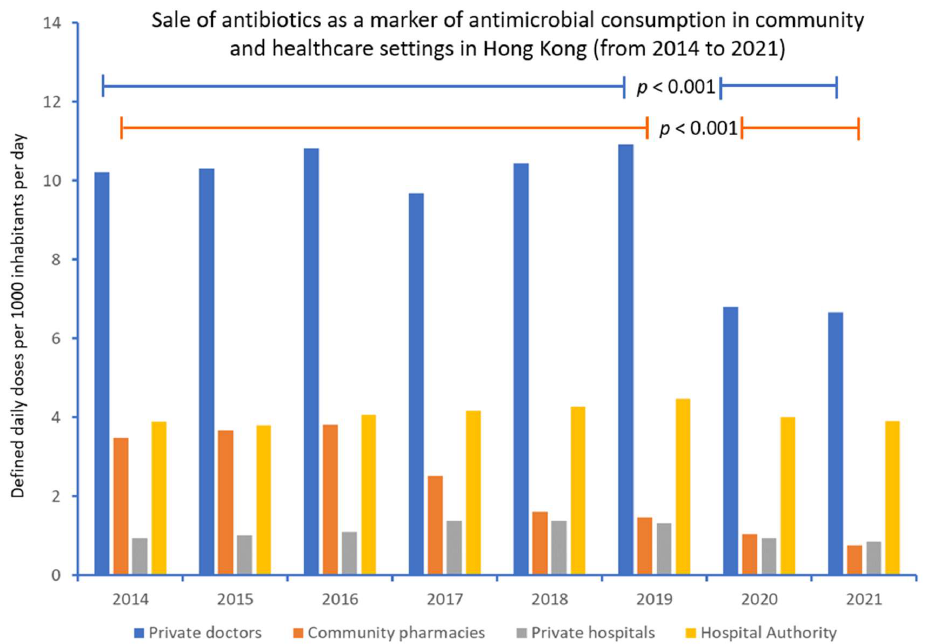
Figure 2. Supply of antibiotics as a marker of antimicrobial consumption in community and healthcare settings in Hong Kong (from 2014 to 2020).